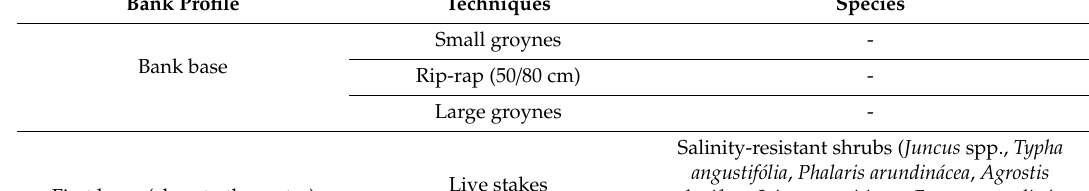
Figure 4. Planned techniques and vegetation species along the bank profile designed for the Cardielos site.